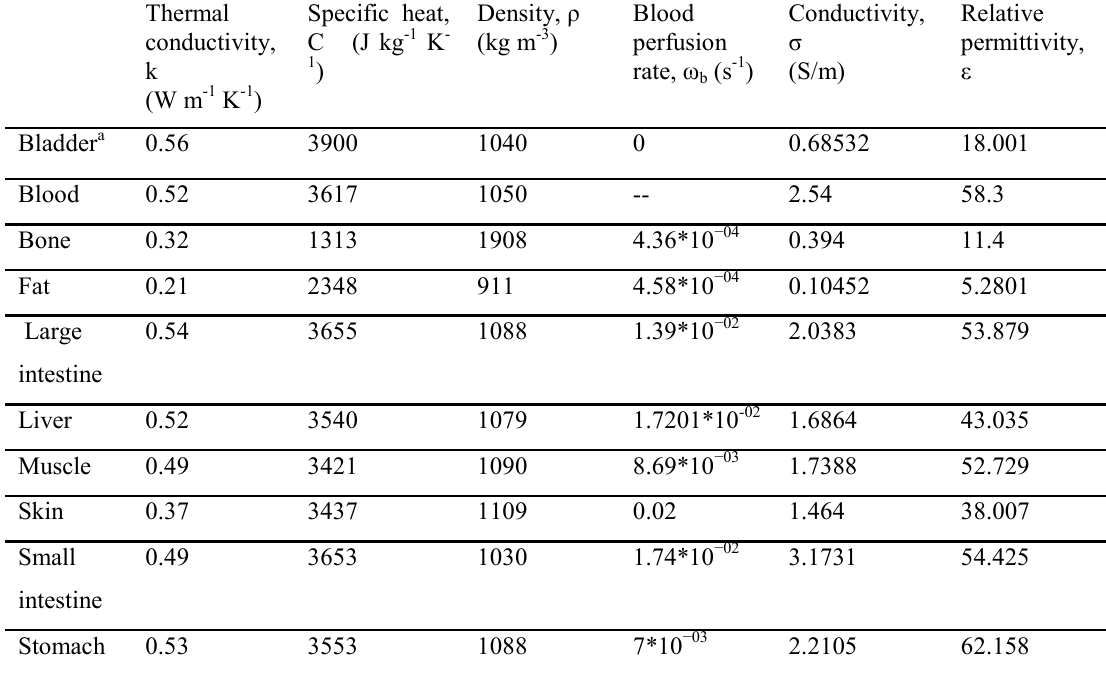
Table 1 : Thermal and dielectric properties of tissues at 2450 MHz [36,